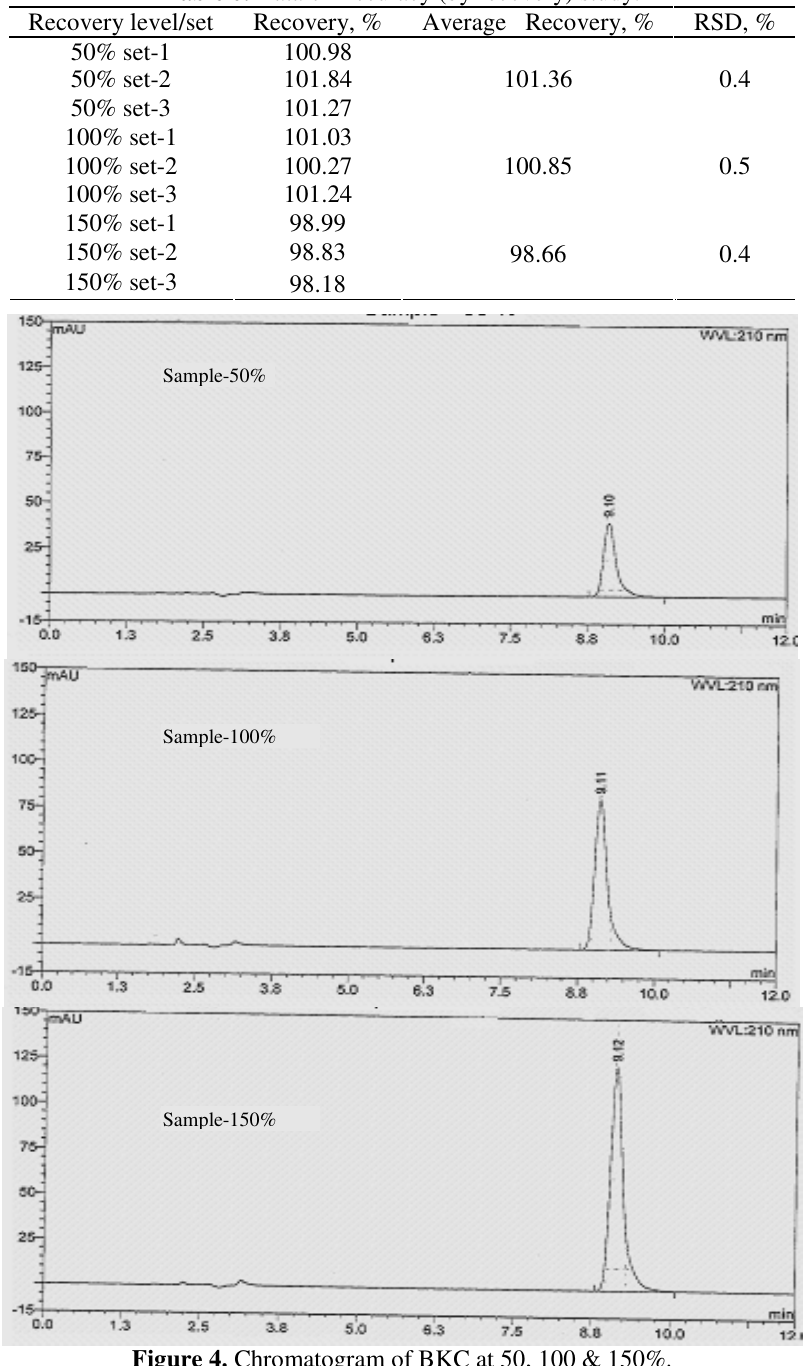
Table 6. Data of Accuracy (by recovery) study.